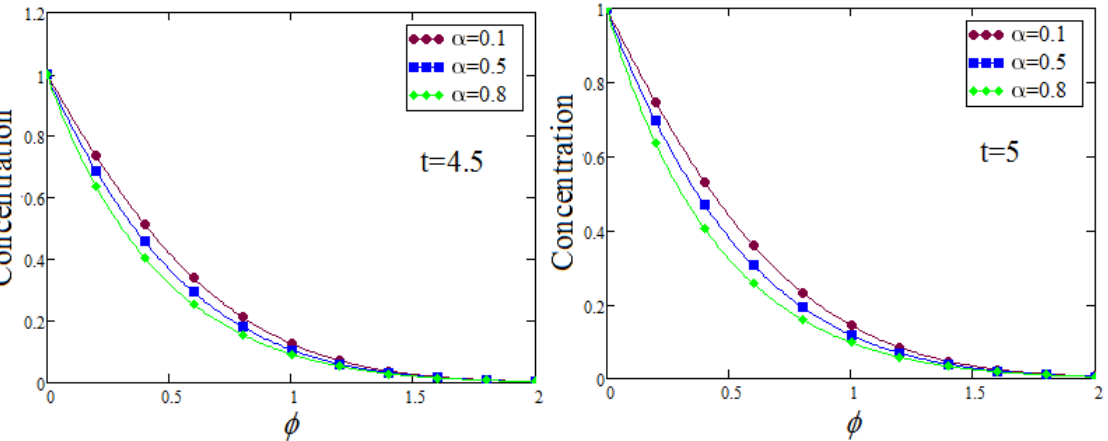
Figure 6. Graphical representations of concentration profile by taking distinct values of α at two different levels of time, when Sc = 9, ℘ = 0.4, β = 0.3 and γ = 0.5.